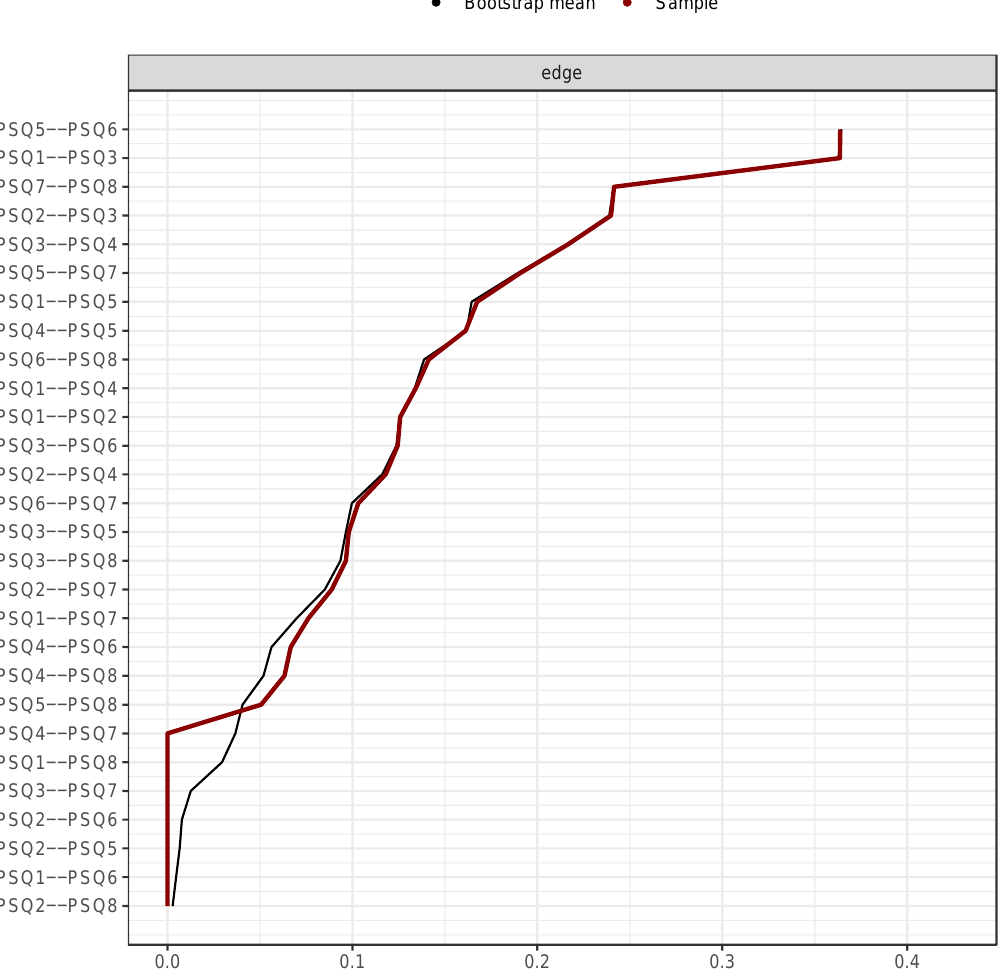
Figure 3. Bootstrapped edge weights for every pairwise node comparison. Note: Black line represents bootstrap mean, red line represents point-estimates of each edge weight and the grey shading shows the edge weight 95% confidence intervals.